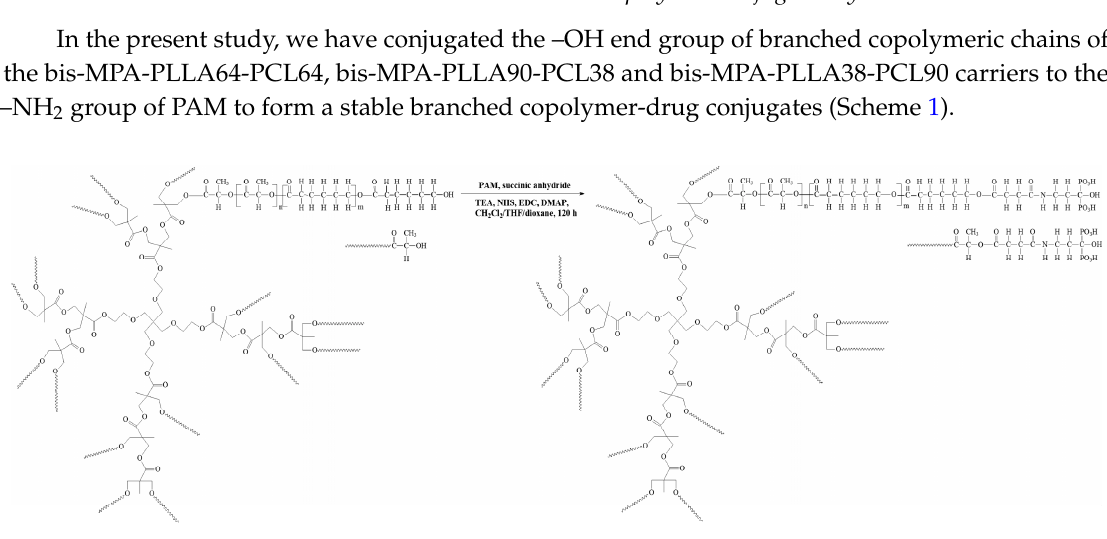
Scheme 1. Schematic outline for the synthesis of the branched PAM conjugates.